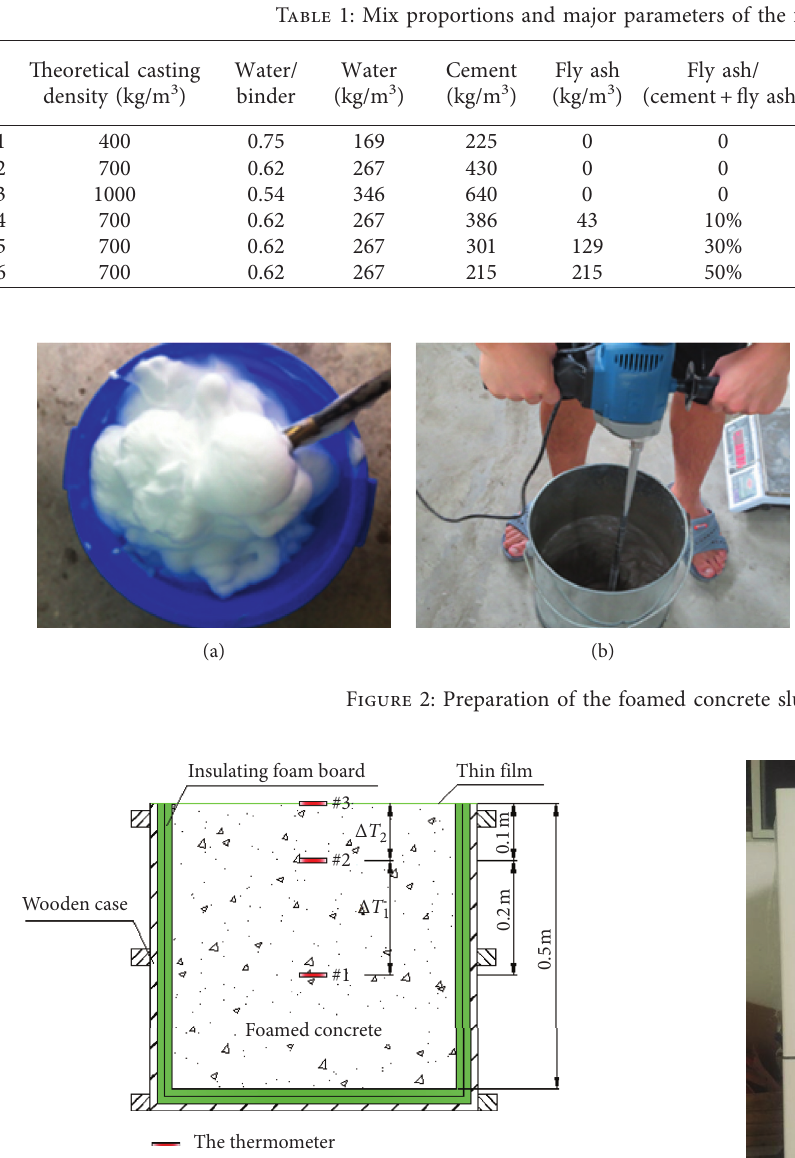
Figure 3: Profile model of the test.